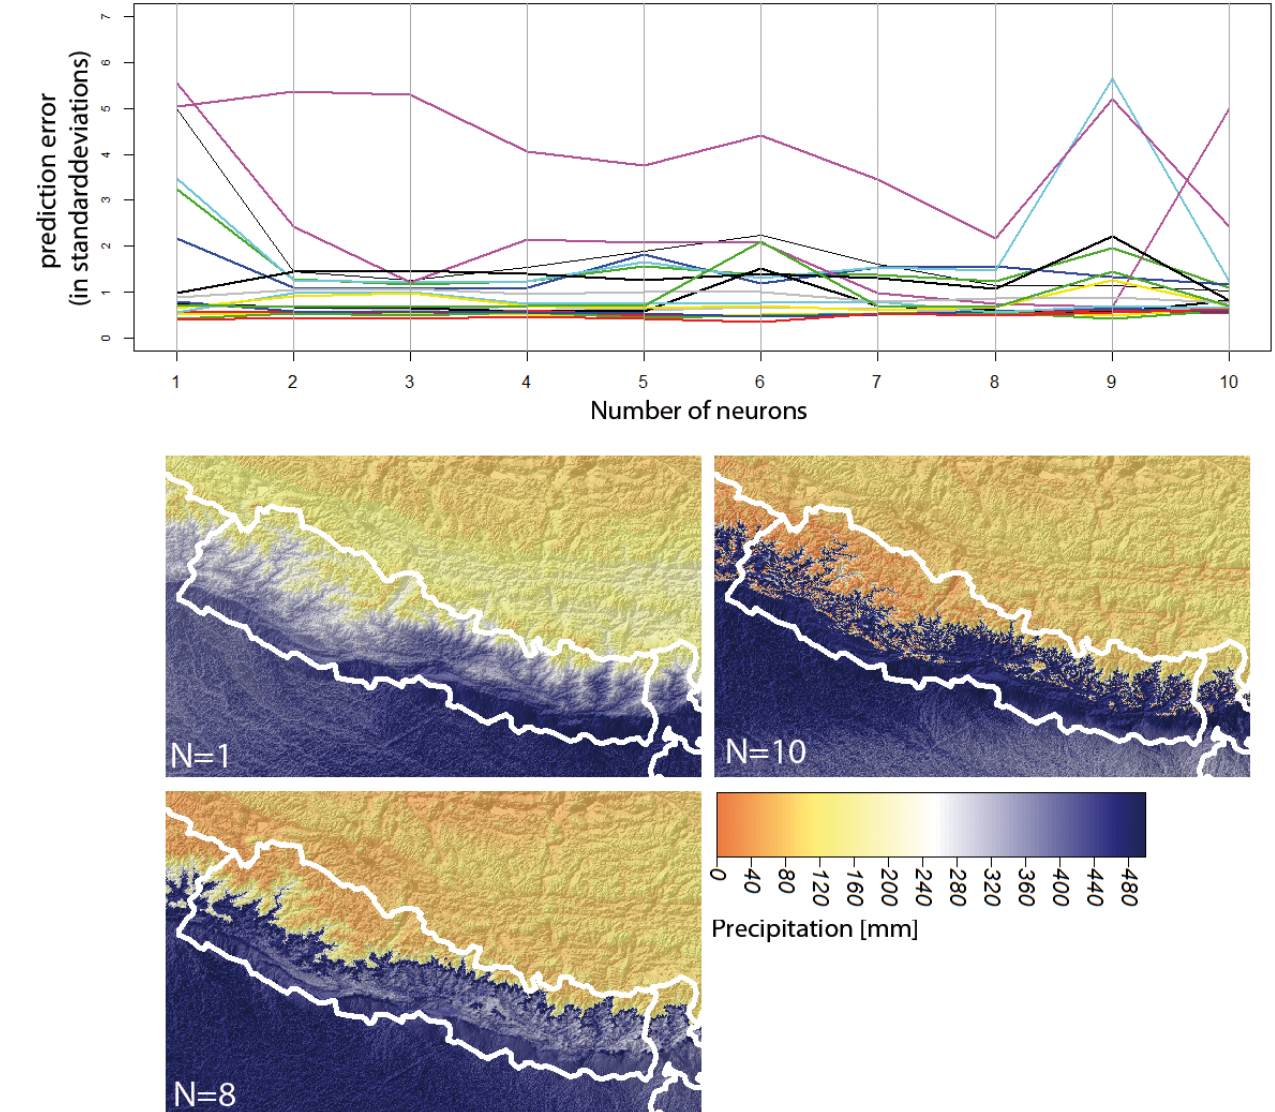
Figure 5. Normalized prediction error of various ANN architectures for 18 independent observational records (top panel) and the modeled distribution of precipitation sums for July 2010 over Nepal based on ANN architectures with N = 1, N = 8 and N = 10